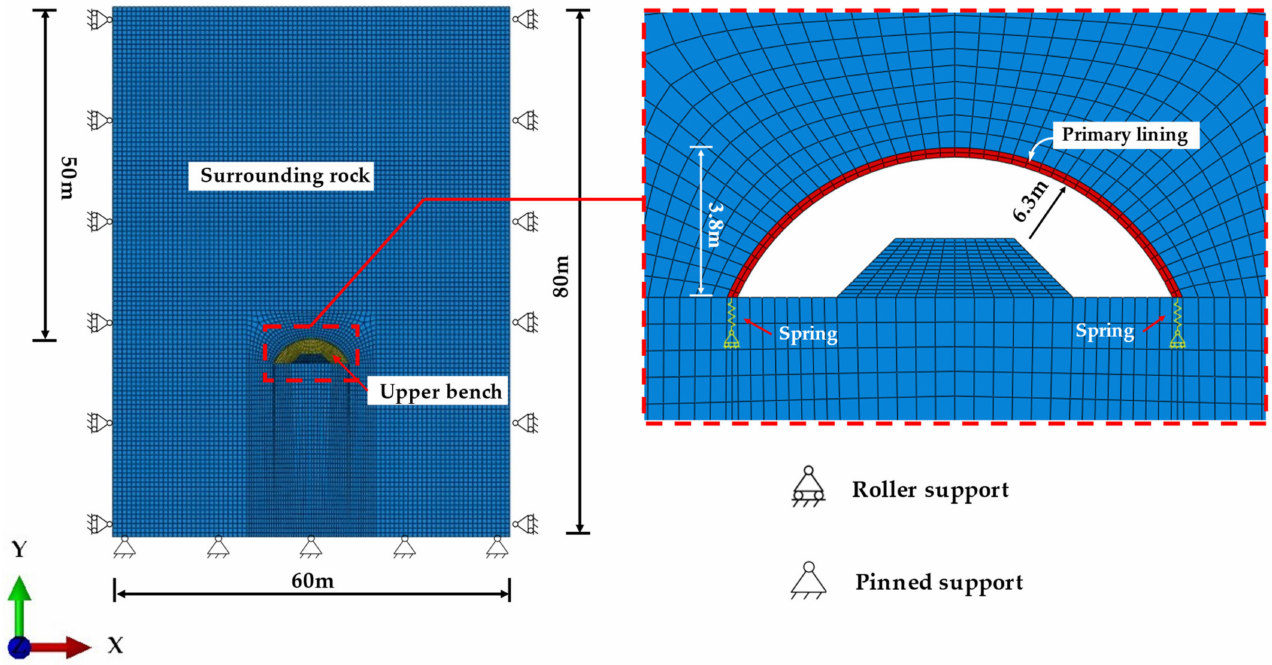
Figure 12. Finite element calculation